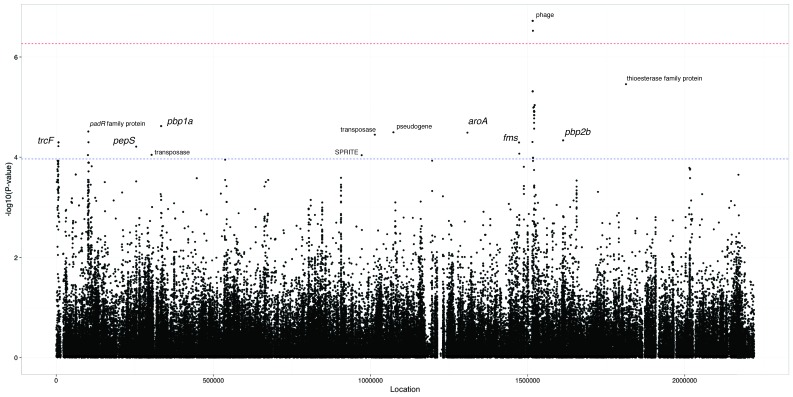
Manhattan plot of SNPs associated with carriage duration.The significance of each SNP’s association with carriage duration against its position in the ATCC 700669 genome is shown. The red line denotes genome-wide significance (α<0.05 Bonferroni corrected with 92487 unique tests), and the blue line suggestive significance (2.3 orders of magnitude below significant, following convention). Loci reaching suggestive significance are labelled with their nearest annotation, as in Table 4.10.7554/eLife.26255.026Figure 5—source data 1.Plot file for Manhattan plot, with coordinates and -log10 transformed p-values of all tested SNPs.